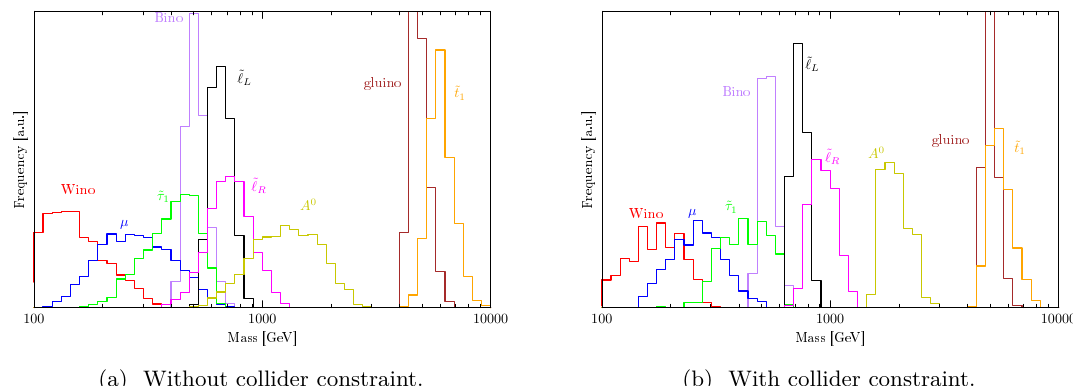
(b) With collider constraint. > 124 GeV h 0